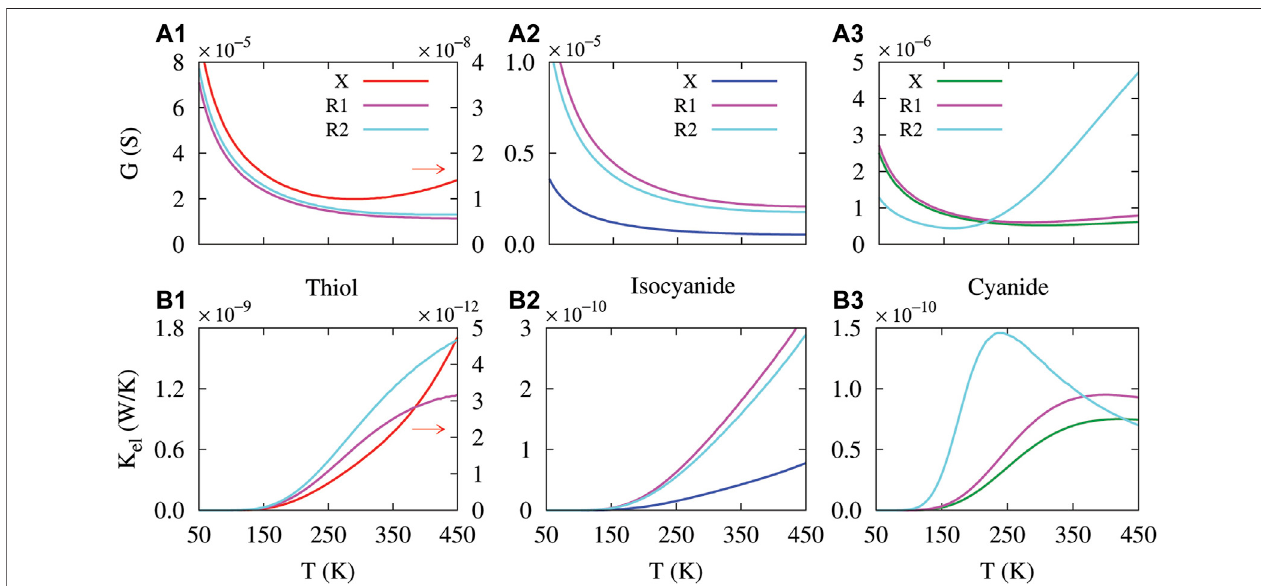
FIGURE 5 | Temperature dependency of the electrical conductance (A1-A3) and electron contribution to the thermal conductance (B1-B3) in the molecular junction perturbed with the amine side group in R1 and R2 positions. The molecule was connected to the Au electrodes via thiol ( fi rst column), isocyanide (second column) and cyanide (third column) anchoringgroups. The electrical conductance and electronic thermal conductance of theunperturbed molecular junction (labeled X) are depicted as a reference. Colored arrows indicate that the corresponding curve is depicted against y2-axis (right)